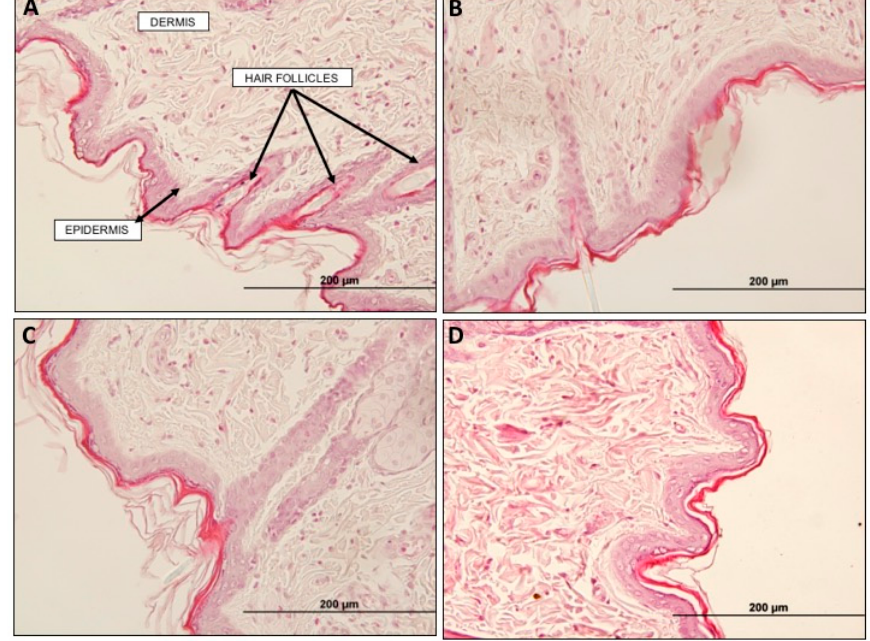
Figure 4. Histology of the rat skin samples. ( A ) Control; ( B ) Commercial cream; ( C ) NP formulation; ( D ) Na-DOC gel.